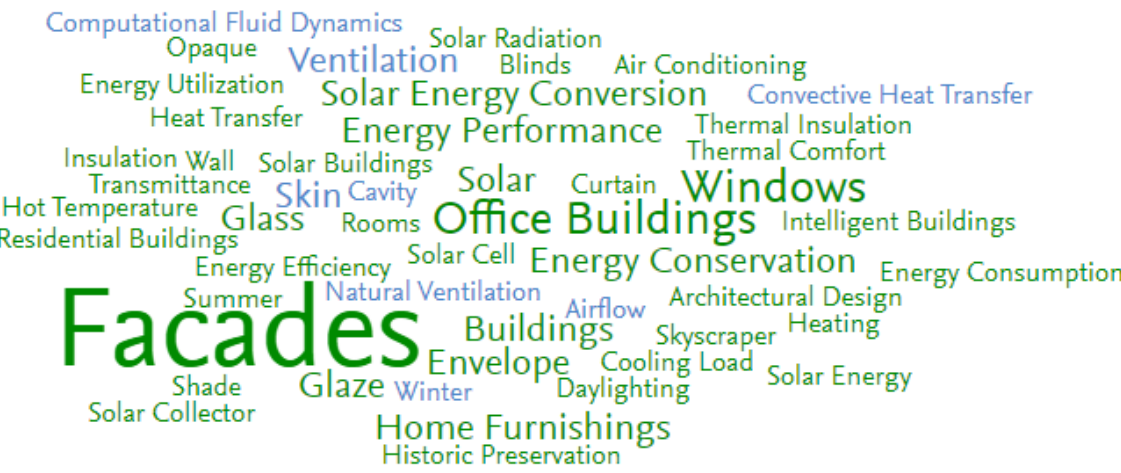
Figure 3. Visualization of scientific landscapes by indexed keywords.